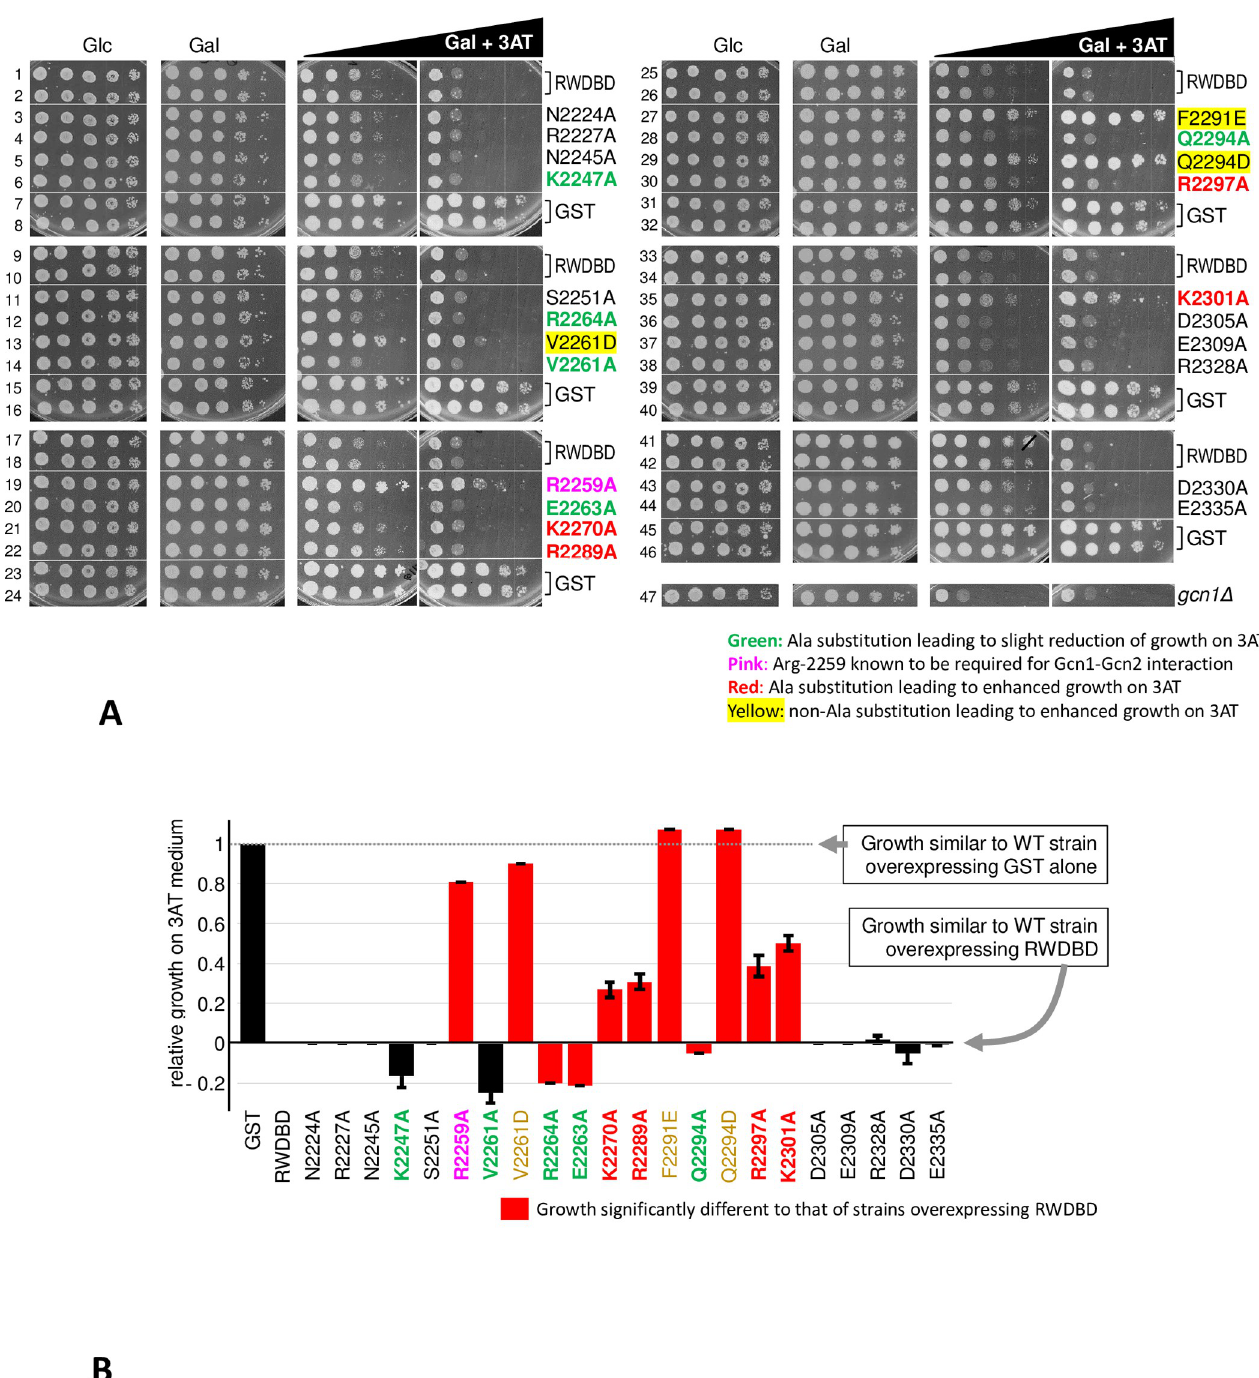
Fig 1. Screening for single amino acid substitutions that modulate the dominant negative effect elicited by the overexpressed RWDBD. (A) Wild-type yeast strain H1511 was transformed with plasmids expressing GST alone or GST-tagged RWDBD from a galactose inducible promotor. The RWDBD was either un-mutated (RWDBD), or contained single amino acid substitutions as indicated. As control, the isogenic gcn1 Δ strain H2556 was transformed with GST alone. Transformants were grown to exponential phase, subjected to 10-fold serial dilutions, and aliquots were transferred to solid medium containing glucose (Glc) or galactose (Gal) as carbon source, as well as 3-amino-1,2,4-triazole (3AT), as indicated. 3AT concentrations were 30 and 120 mM (left and right panels underneath the black triangle labelled Gal+3AT). The assays were performed at least 4 times, and a sample result is shown. The same strains were grown on Glucose and Glucose + 3AT medium (not shown). Under these conditions, where the RWDBD variants are not overexpressed, the 3AT resistance of H1511 was not altered, suggesting that the effects seen on Gal+3AT are truly due to the overexpression of the RWDBD variants. (B) The growth in (A), from four